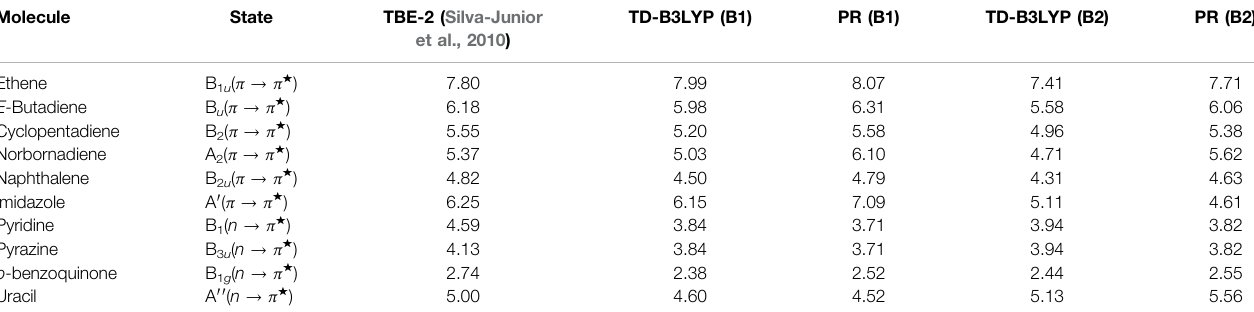
TABLE 14 | E 0 S (in eV) in organic dyes, using B3LYP functional. See Roy et al. (2021) for details. Molecule